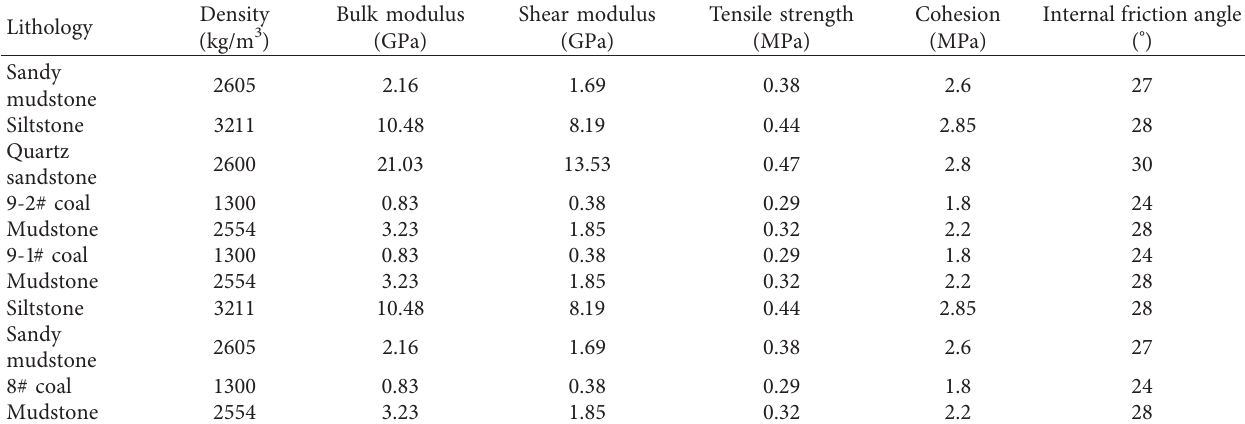
Table 2: Mechanical parameters of roof and floor rock strata at the coal seam.